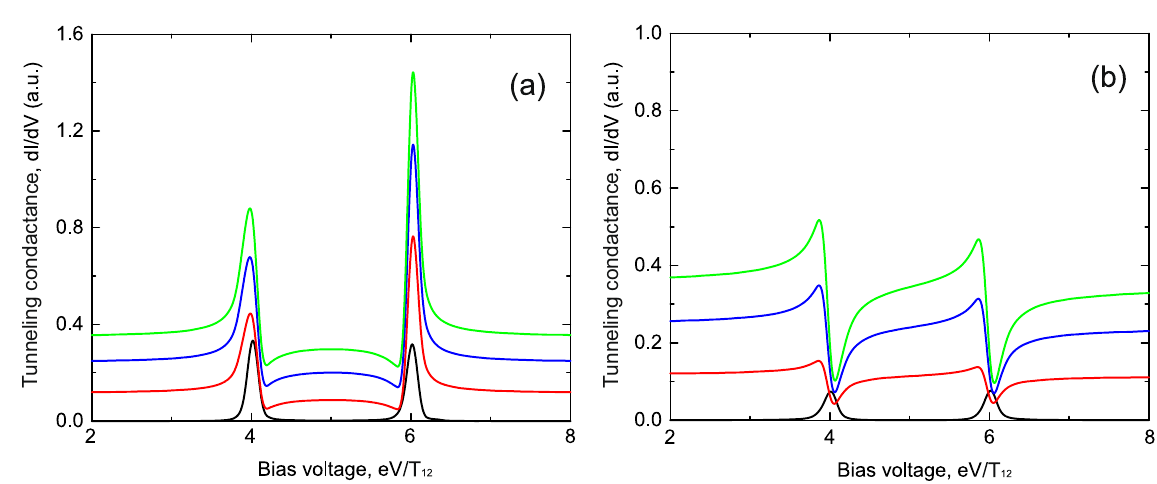
Figure 7. (Color online) Tunneling conductance as a function of applied bias voltage for the impurities configuration shown in Fig. 3b in the case of the intermediate system formed by a chain of two impurity atoms. (a) Demonstrates results in the absence of Coulomb interaction; (b) shows calculation results in the presence of infinitely large Coulomb interaction. Black curves correspond to the tunneling rates t L 1 = 0.1 T , t R 2 = 0.3 T 12 , T = 0.0 ; red curves correspond to the tunneling rates t L 1 = 0.1 T , t R 2 = 0.3 T 12 , T = 0.6 T 12 ; blue curves correspond to the tunneling rates t L 1 = 0.1 T , t R 2 = 0.3 T 12 , T = 1.0 T 12 ; green curves correspond to the tunneling rates t L 1 = 0.1 T , t R 2 = 0.3 T 12 , T = 1.2 T 12 . Parameters ε 1 = ε 2 = 5.0 T 12 , T 12 = 1 are the same for all